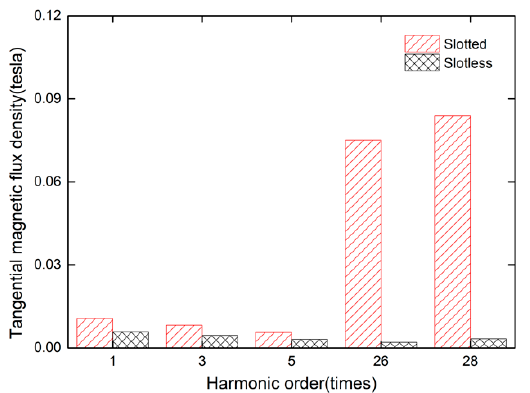
Figure 4. Tangential magnetic flux density harmonic order at no − load.